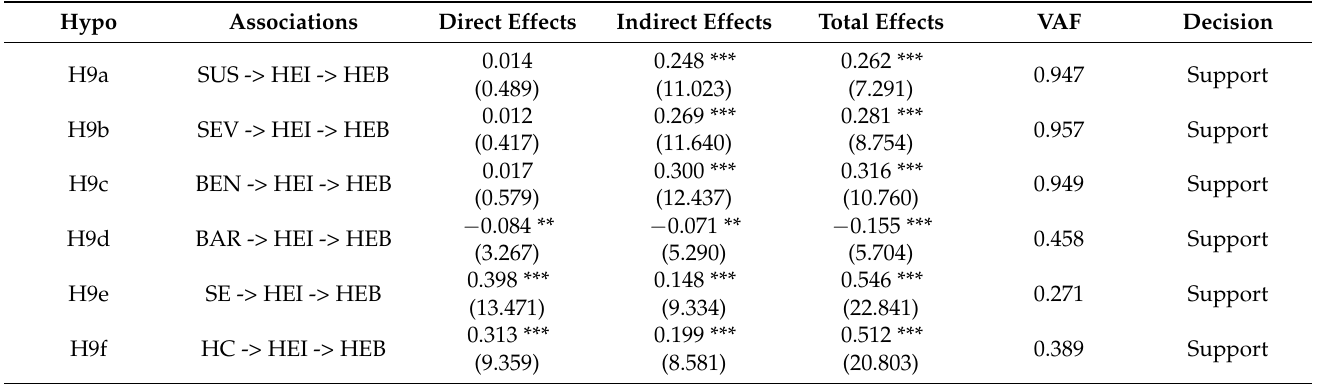
Table 5. Mediating